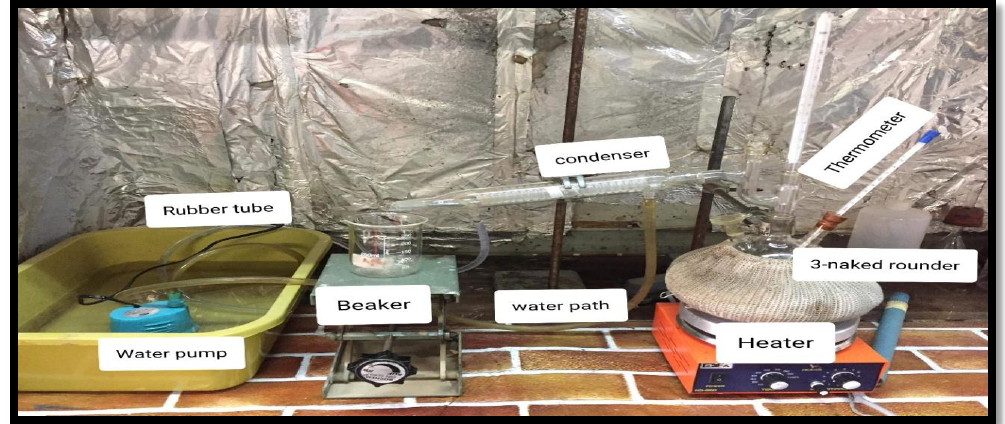
Fig.3: The procedure steps of the purification of Pyrrole